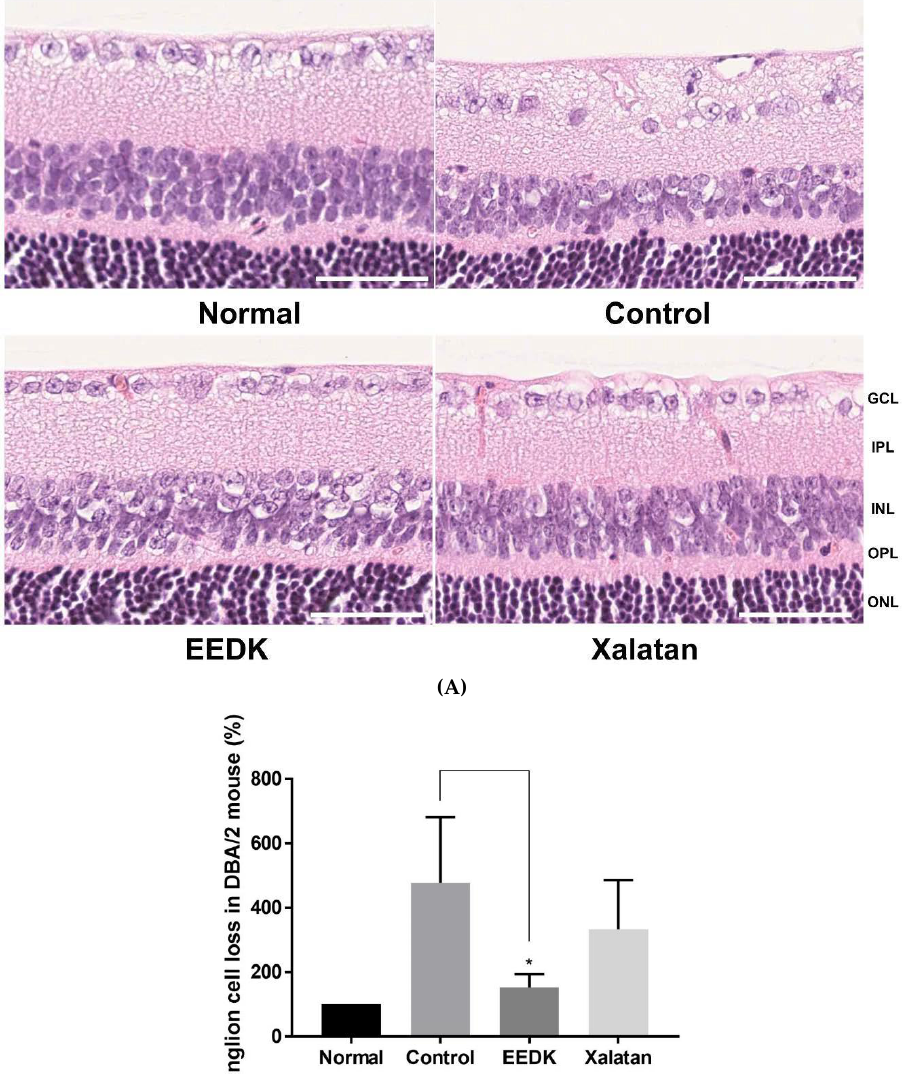
Figure 7. Effect of EEDK on ganglion cell loss in DBA/2 mouse. ( A ) Enucleated eyeballs were fixed Figure 7. E ff ect of EEDK on ganglion cell loss in DBA / 2 mouse. ( A ) Enucleated eyeballs were fixed for para ffi n embedding. The tissue slides were stained with H&E solution, and observed using Nanozoomer. The scale bar represents 50 µ m. GCL, ganglion cell layer; IPL, inner plexiform layer; INL, inner nuclear layer; OPL, outer plexiform layer; ONL, outer nuclear layer. ( B ) The bar graph shows quantitative analysis of the ganglion cell loss rate (%). Values represent the mean ± S.E.M. for 3 animals (* p < 0.05, mean ±